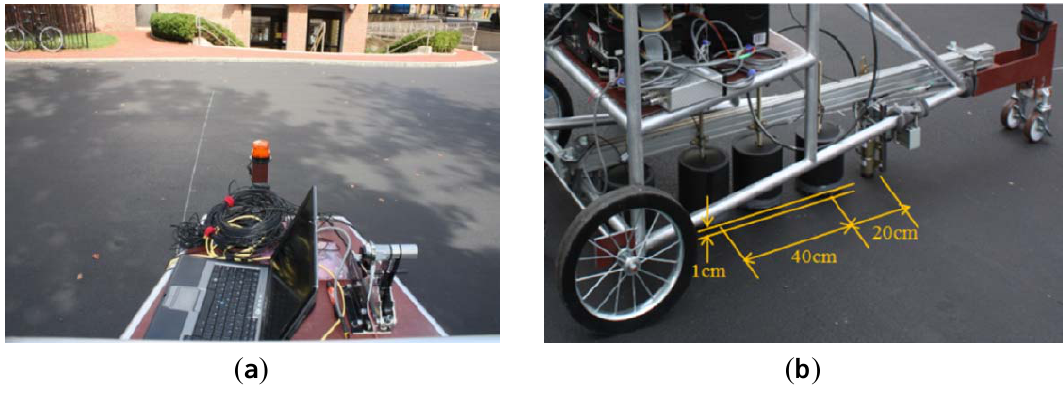
Figure 9. Remotion test on asphalt pavement. ( a ) Mobile sensing with MASS. ( b ) Test